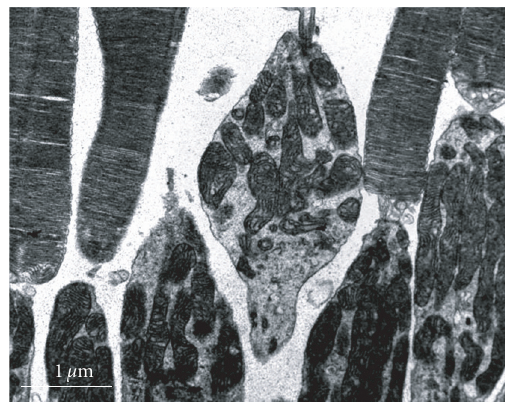
Figure 5: Shortly after suction 20 seconds, inner section cell member is integrity, the outer section is in order ( × 10000).